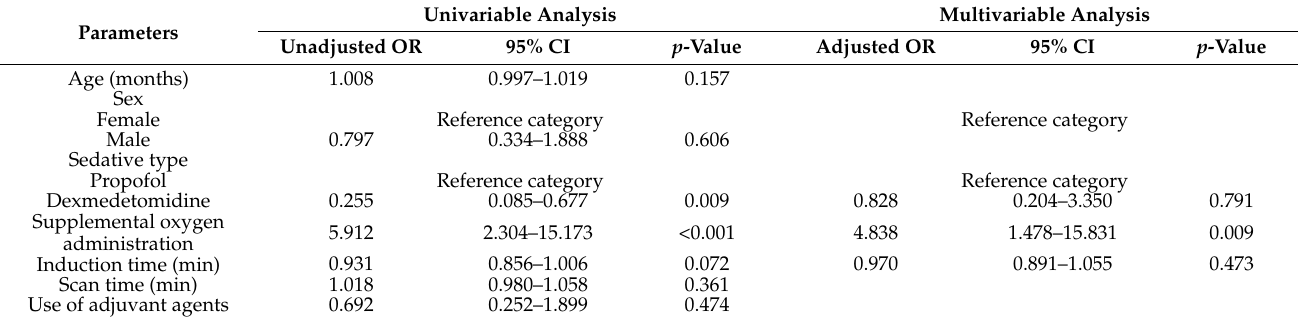
Table 5. Logistic regression analysis of factors associated with the occurrence of